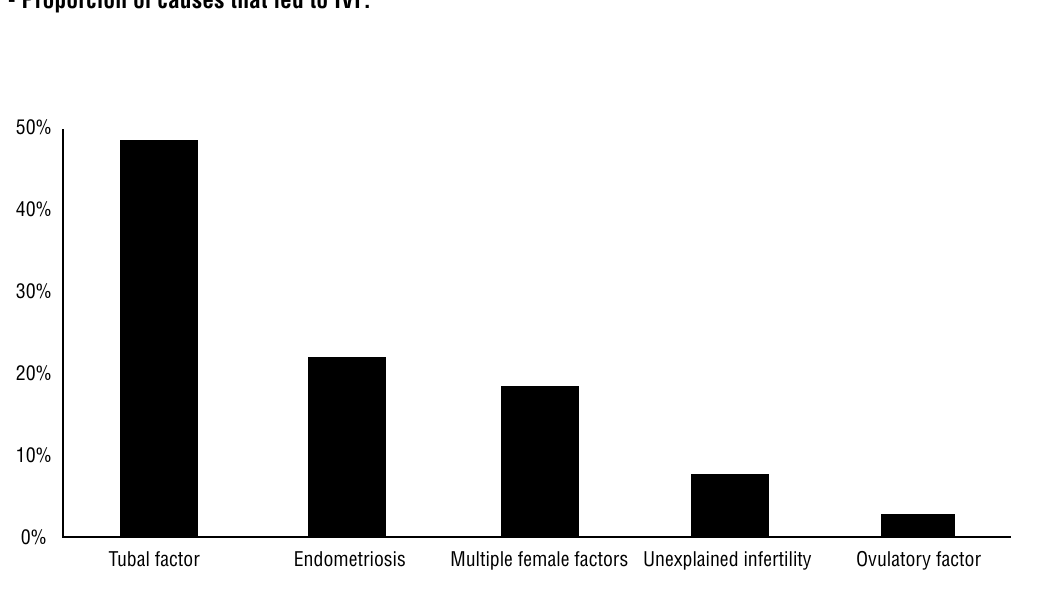
Figure 1 - Proporcion of causes that led to